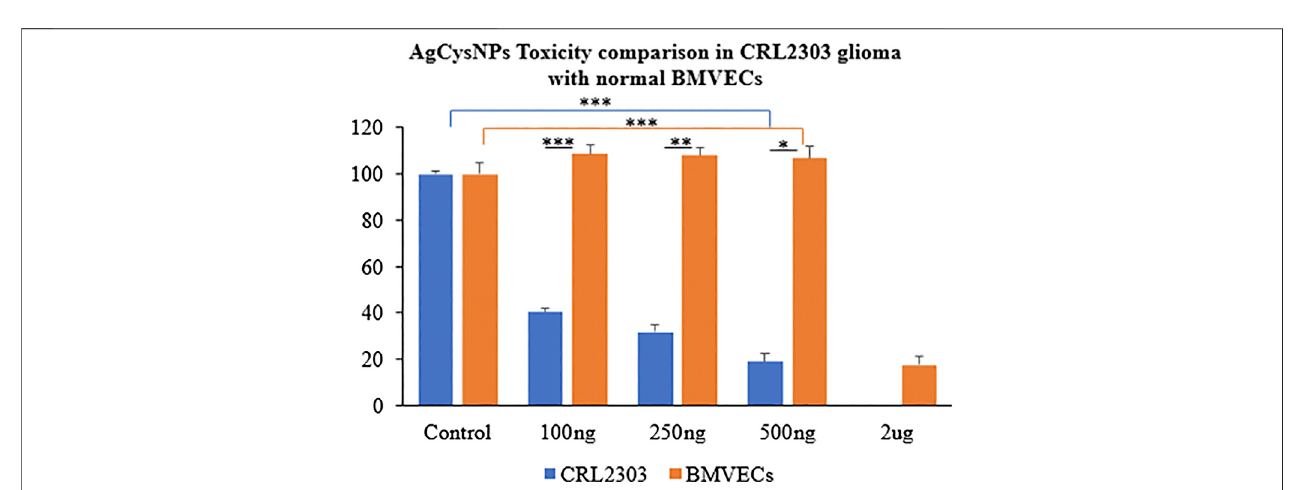
FIGURE 8 | Toxicity comparison between CRL2303 glioma cells and normal BMVECs due to treatment with AgCysNPs showing high toxicity imparted by the silver-cystine biohybrid to glioma cells from concentration of 100 – 500 ng/ml but BMVECs requiring about four fold (2 μ g/ml) more of the materials compared to glioma cellstoshowsameleveloftoxicityaswasobservedfor500 ng/mlinglioma cells.Datarepresentaverageoverthreeexperiments( N (cid:2) 3)withtriplicated wells( n (cid:2) 3).The error bars represent SEM values, “ *** ” represent p < 0.001, “ ** ” represent p < 0.01 and “ * ” represent p < 0.05.